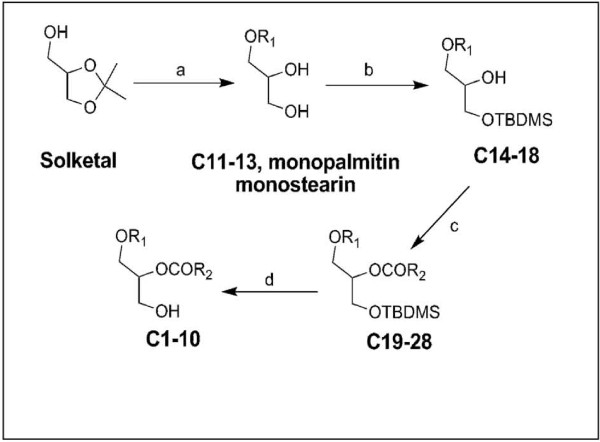
Scheme showing the syntheses of phosphoethanolamine plasmalogen precursors C1-3, C6-10, and diacylglycerols C4 and C5, test compounds for the study. Reagents: (a) i R1Br, NaH/DMF or R1SO4CH3, NaH/THF, reflux; (ii) 10% HCl, reflux; (b) TBDMS-Cl, imidazole/DMF; (c) R2COCl, DMAP, Pyridine, Toluene; (d) TBAF/THF, Imidazole, - 20°C